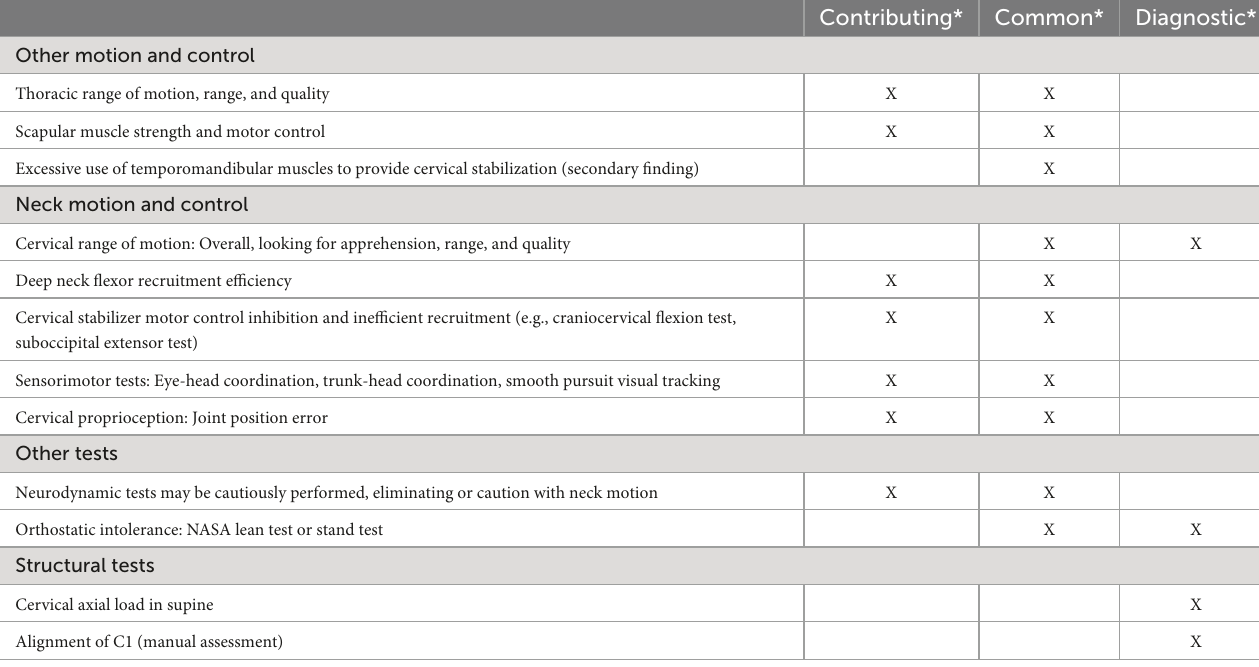
Contributing* Common*